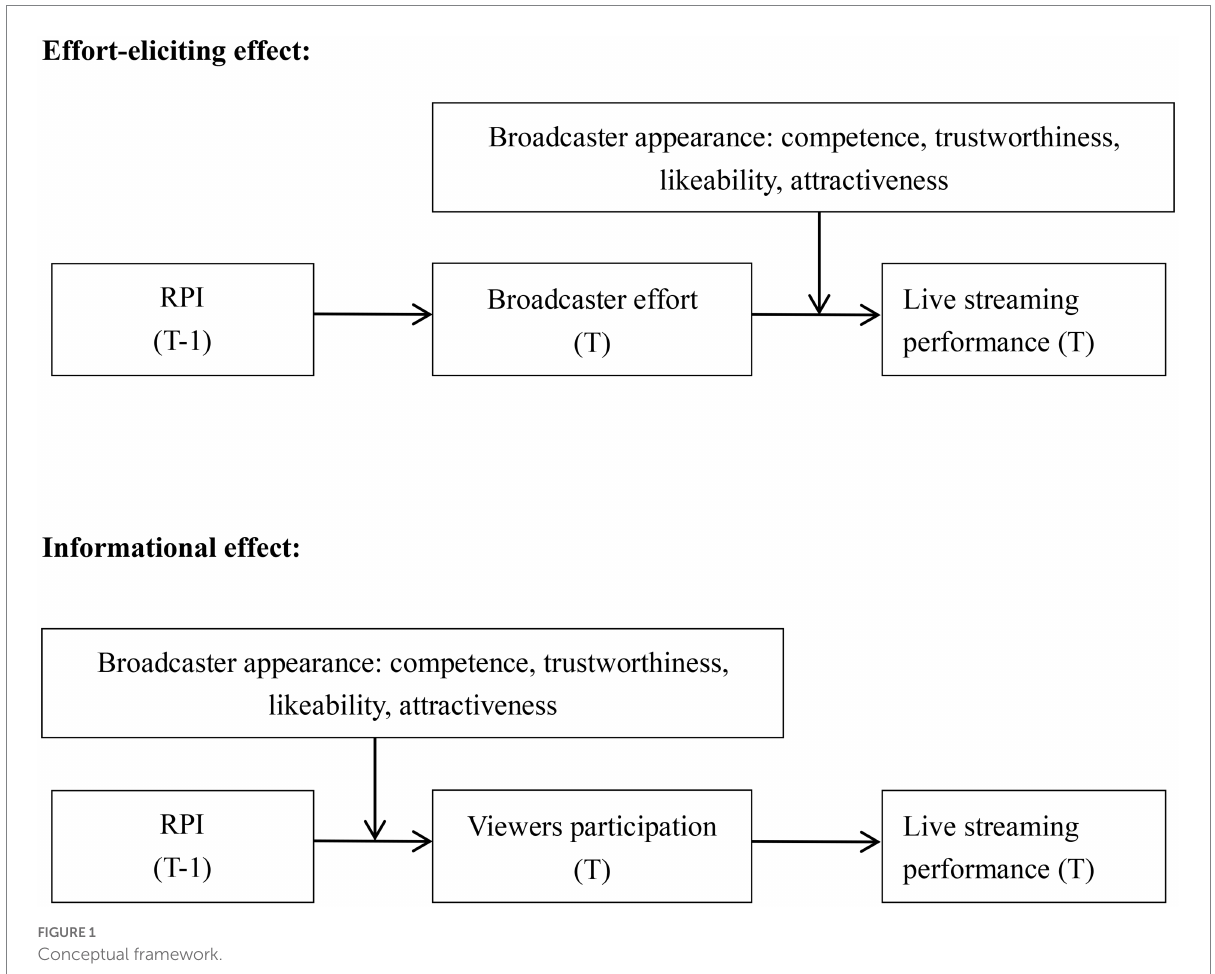
FIGURE 1 Conceptual